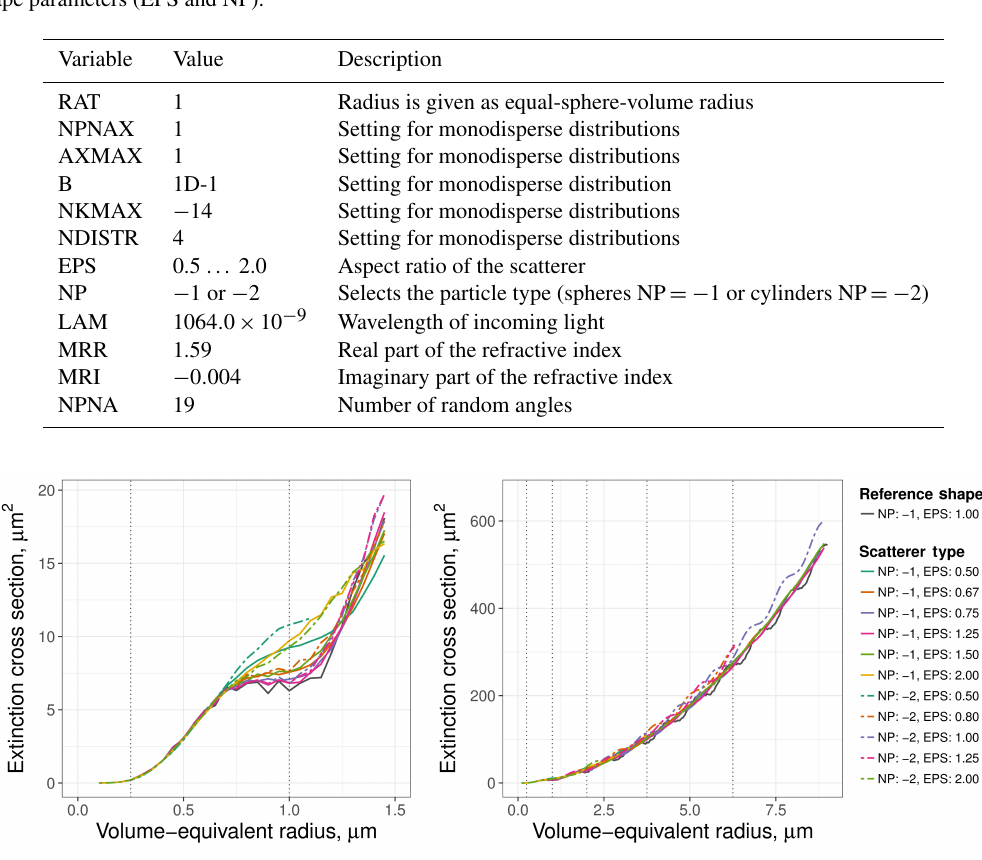
Table 2. Settings of the T-matrix procedure for the particle shape sensitivity study. The parameters were kept constant during the study except the particle shape parameters (EPS and NP).